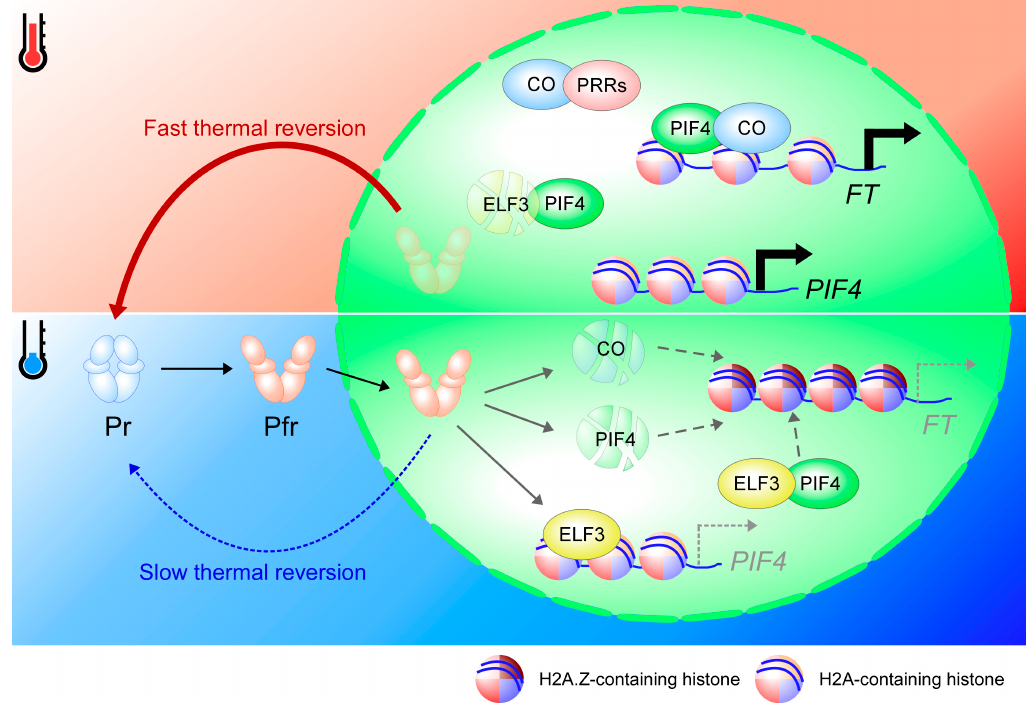
Figure 1. Mechanism of ambient temperature-responsive flowering involving histone variant eviction, phytochromes, and the circadian clock. At high ambient temperatures (red thermometer), H2A.Z is evicted and replaced by the canonical histone H2A. This facilitates the binding of PIF4 and CO to the FT promoter and activation of the transcription of FT. Fast thermal reversion of phyB at warm temperatures (bold red arrow) allows stabilization of CO and PIF4 to maintain robust FT expression. CO protein is stabilized by interacting with PRRs, which are circadian clock components, while the degradation of ELF3 by PIF4 alleviates the repression of PIF4 . By contrast, at low ambient temperature (blue thermometer), H2A.Z is present in the FT promoter, blocking the access of transcription factors to the FT promoter. Slow thermal reversion (dashed blue arrow) of phyB at low temperatures induces the degradation of CO and PIF4 proteins, but maintains the stability of ELF3 to repress PIF4 . ELF3 also likely blocks the function of PIF4 by direct interaction. Fragmented ovals indicate degraded proteins. Arrows and dashed arrows in the nucleus denote activation and inability to activate, respectively.